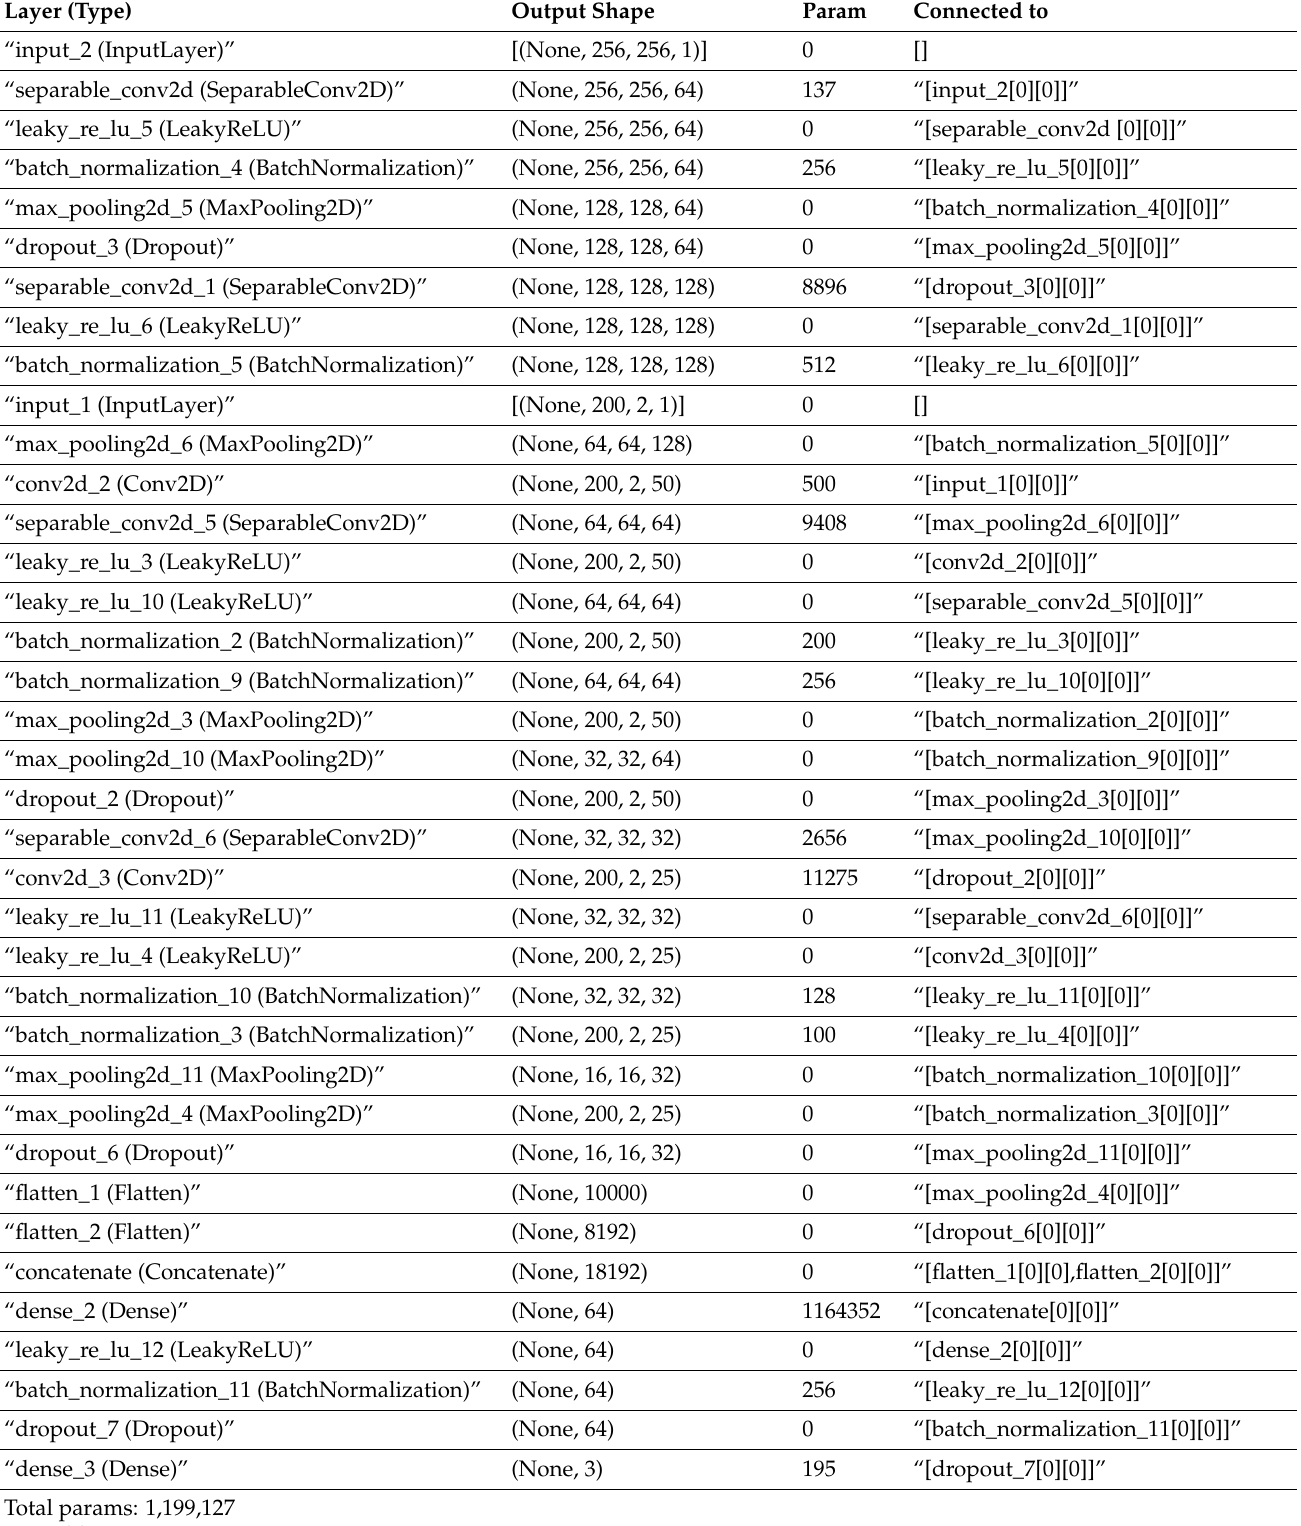
Table 4. Parameter details of used Multi-headed